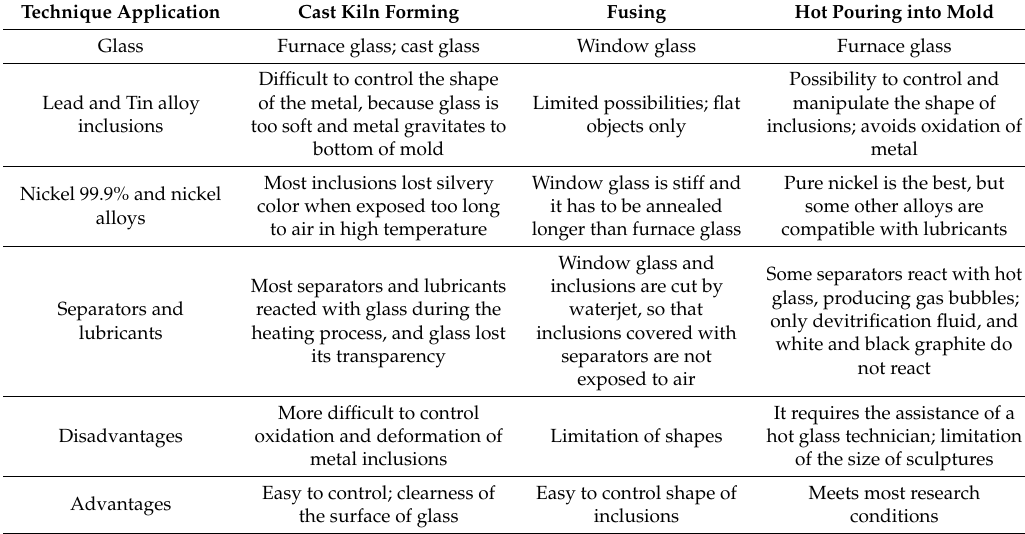
Table 2. Comparison of hot kiln techniques used in the research.